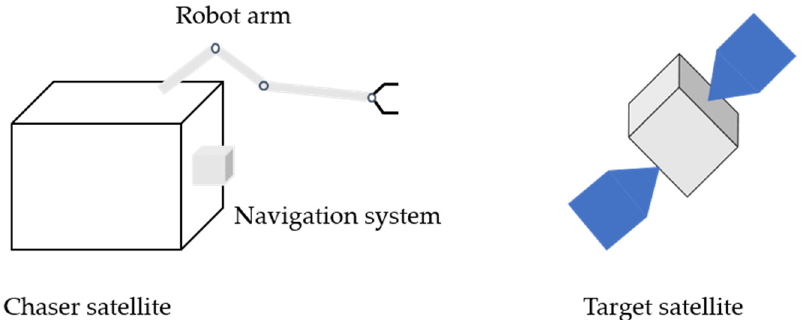
Figure 1. Schematic diagram of the capture mission.